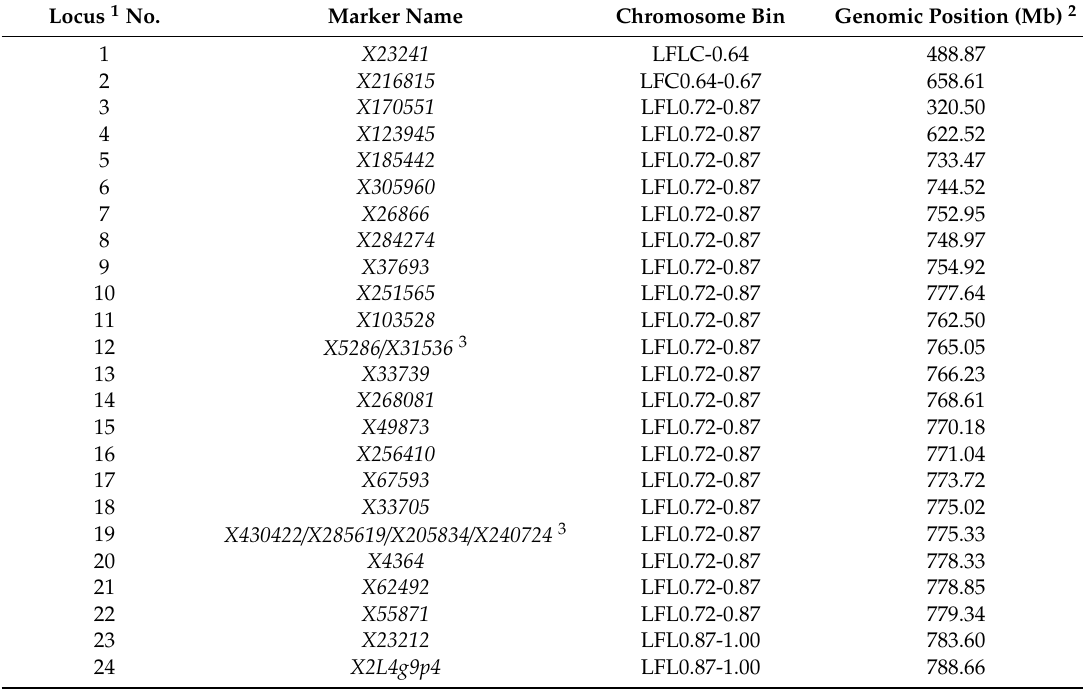
Table 2. Molecular markers used to identify recombinants and physically map Pm57 . Locus 1